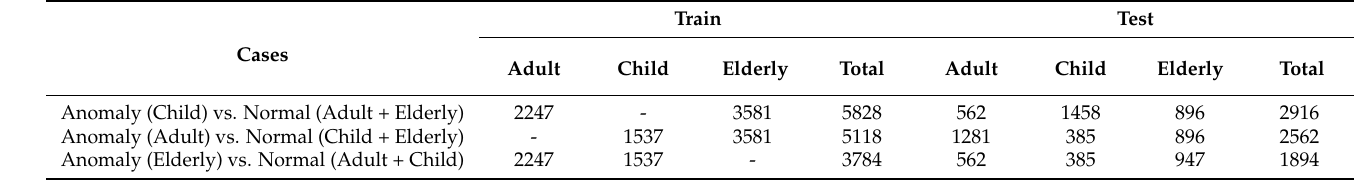
Table 2. The train-test split of the dataset. A total of 80% of two normal-designated class images are used in a cluster during the training without labels, and the remaining 20% of each normal-designated class, as well as the equal-numbered anomaly-designated class images, are used during the inference. Anomaly-designated class images are not used during the